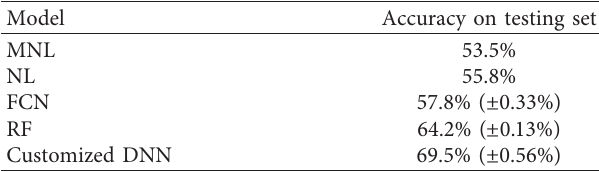
Table 2: Experimental results.